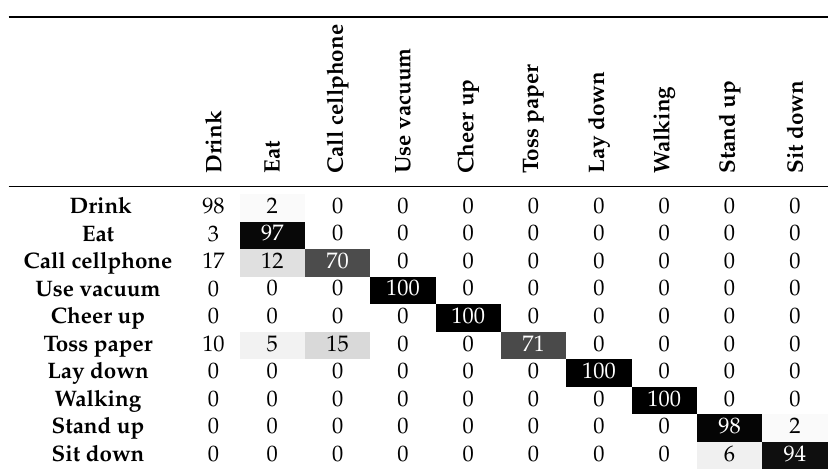
Table 16. Confusion matrix of the proposed method based on the concatenation of Centre-oriented FWMDMMs and spatial information in terms of daily activity 3D dataset.